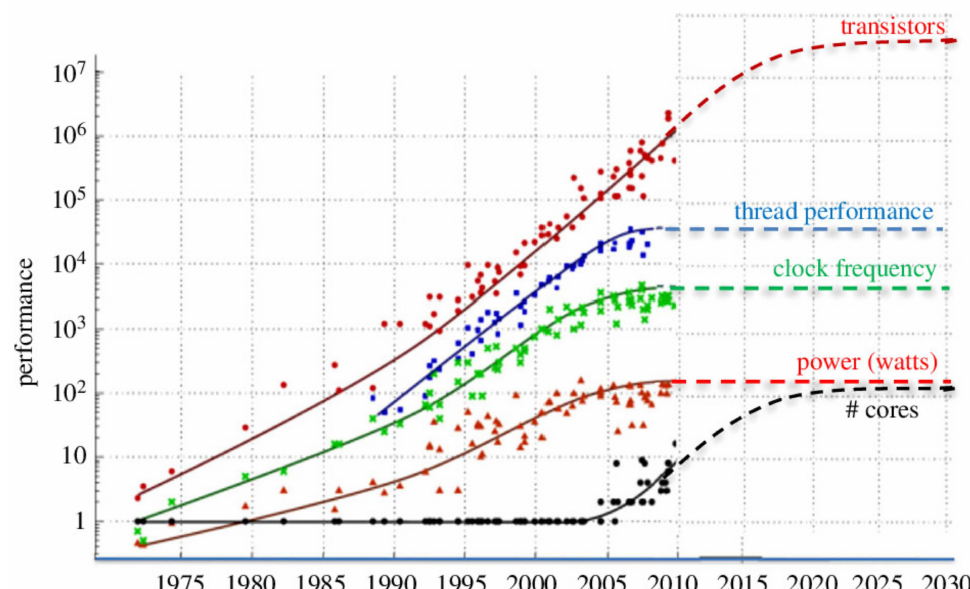
Figure 6. Semiconductor devices production [36].